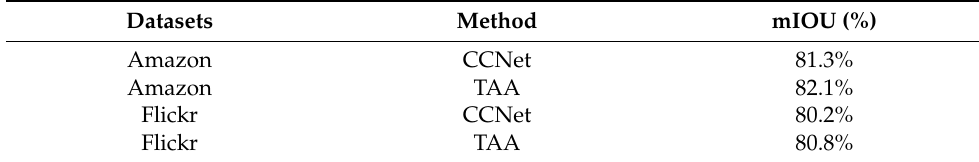
Table 10. Comparison between TAA and CCNet aggregated pixel contextual information perfor- mance.